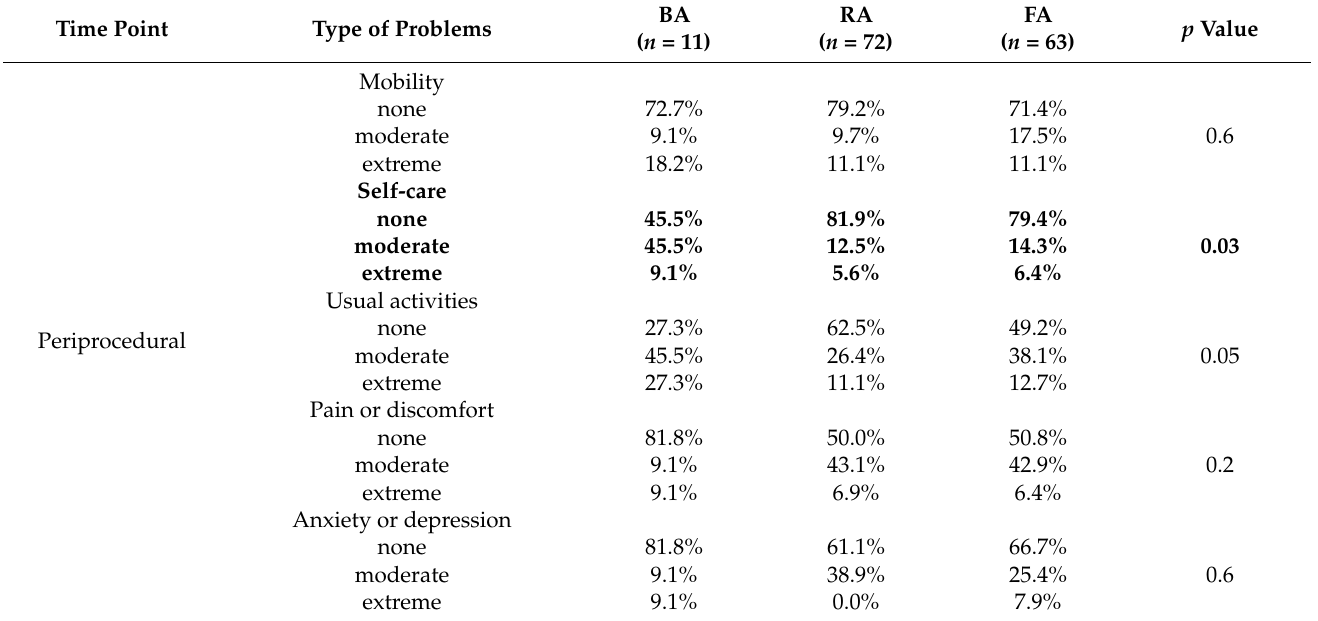
Table 5. Specific answers from the EQ-5D-3L